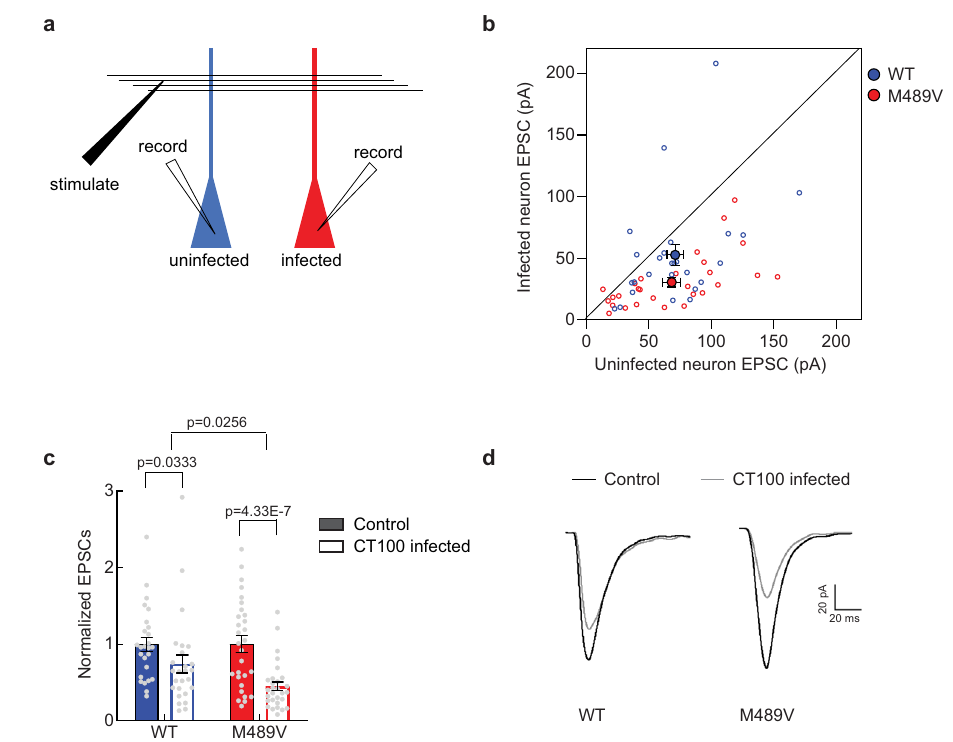
Fig. 4 | The AD-associated PKC α M489V mutation exacerbates A β -induced synaptic depression. a Experimental design of dual-patch whole-cell recordings (see Material and Methods section). b Dot plot showing the individual excitatory post-synaptic currents (EPSCs) in CT100 infected versus uninfected CA1 hippo- campal neurons from WT (blue open circles, N =26) and M489V (red open circles, N =29) mice. Group averages indicated by fi lled circles, error bars indicate SEM. c Bargraphofdual-patchrecordingsforindicatedgroups(samedataasin b , n =26 wt and n =29 M489V CA1 hippocampal neurons); responses were normalized to